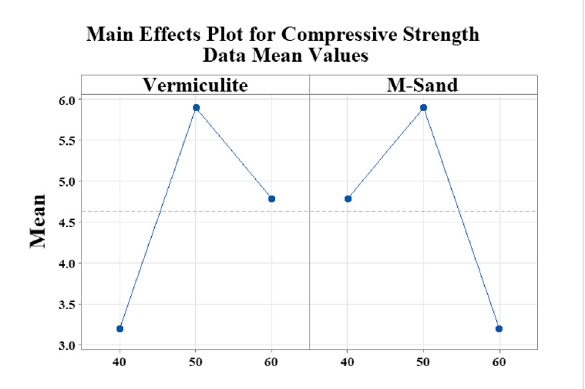
FIGURE 10 Main plot for compressive strength.